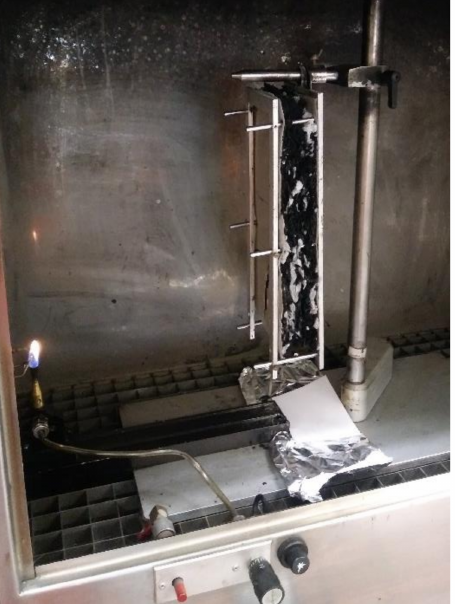
Figure 5. Reaction to fire test set-up for thermal insulation specimens according to the standard ISO 11925-2:2020